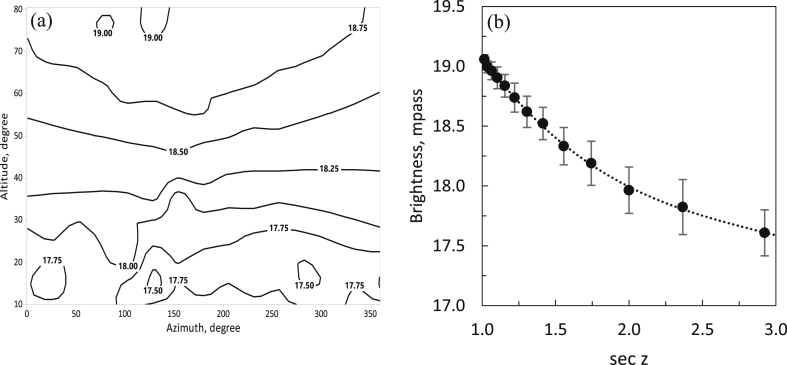
Sky brightness as a function azimuth and altitude (a) and of zenith distance (b).